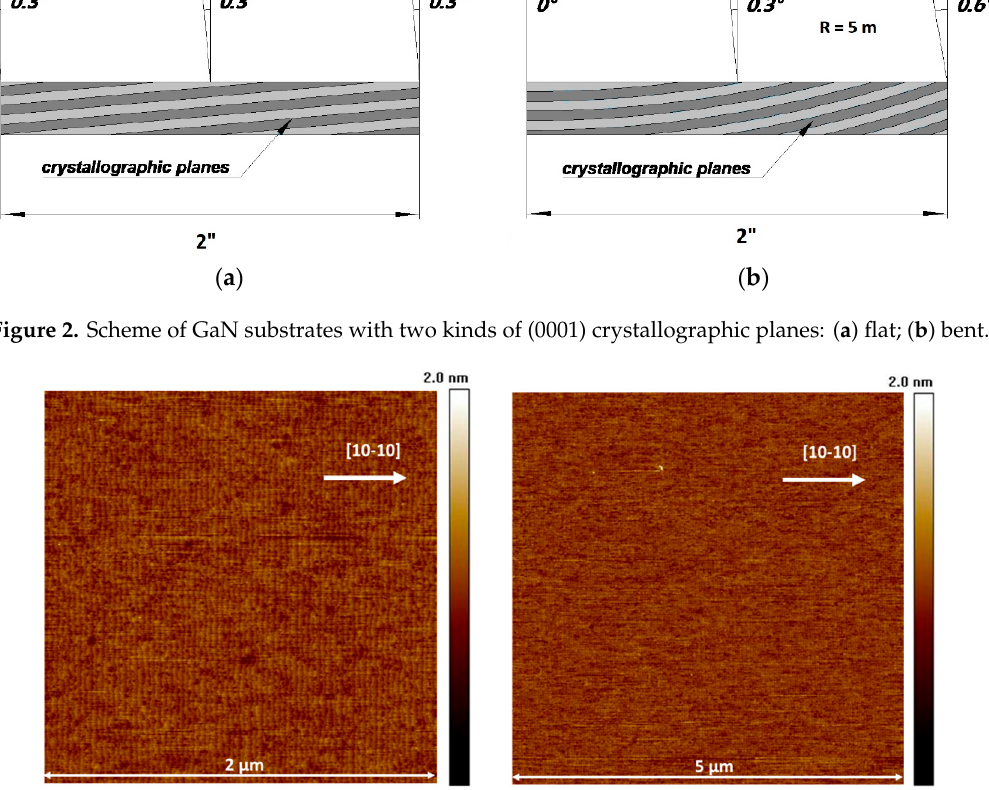
Figure 2. Scheme of GaN substrates with two kinds of (0001) crystallographic planes: ( a ) flat; ( b ) bent. Figure 3. Example of typical atomic force microscopy image of epi-ready (0001) surface of 2-inch ammonothermal GaN wafer fabricated at IHPP PAS: ( a ) 2 µm × 2 µm area and ( b ) 5 µm × 5 µm area. Last but not least, there is a requirement for a GaN wafer regarding its free carrier concentration.